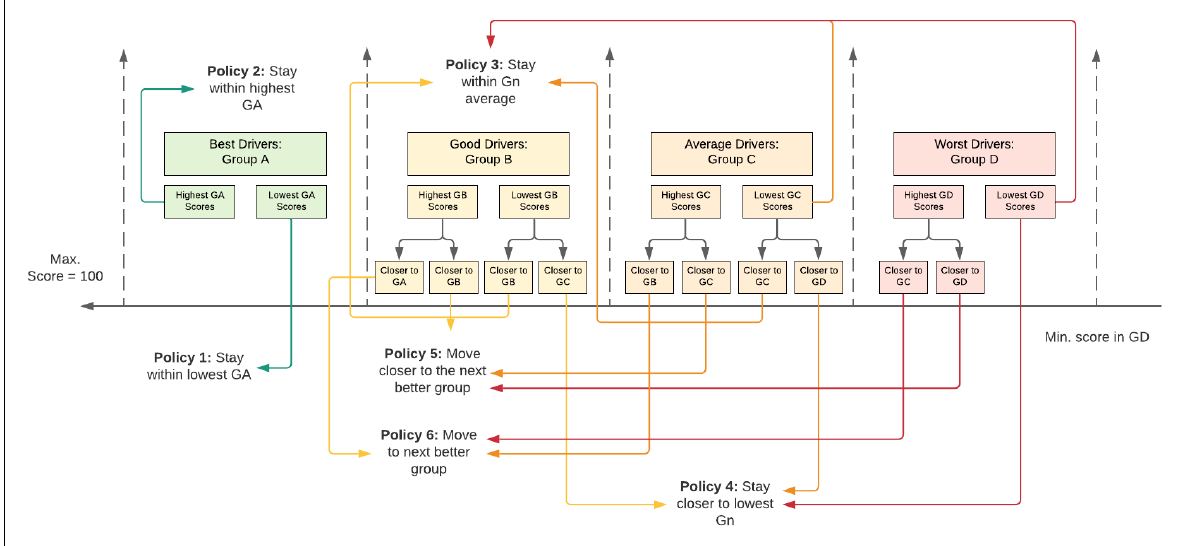
Figure 5. Policies